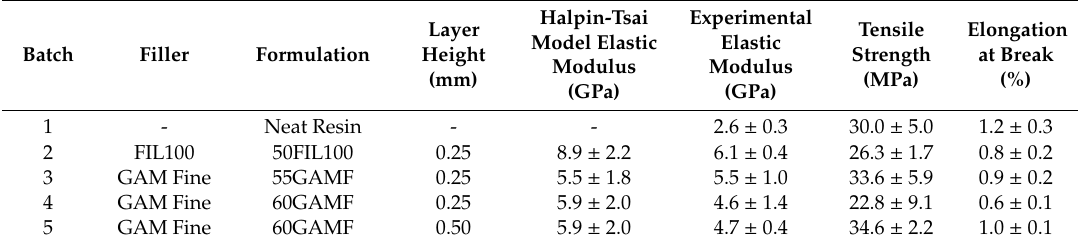
Table 3. Halpin-Tsai model and experimental elastic modulus, tensile strength, and elongation at break values for the neat resin, FIL 100 and GAM Fine-reinforced resins.